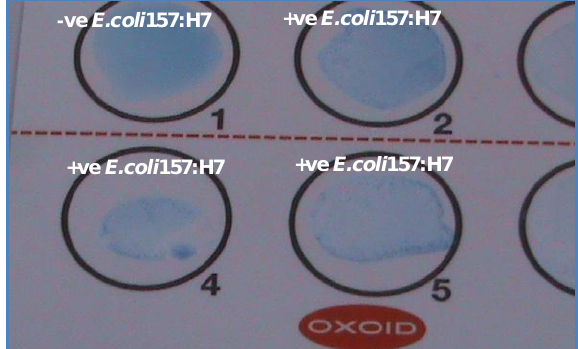
Figure, 2: Positive latex test, 1: Negative agglutination for E.coli O157:H7, 2, 4 and 5 positive agglutination for E.coli O157:H7.